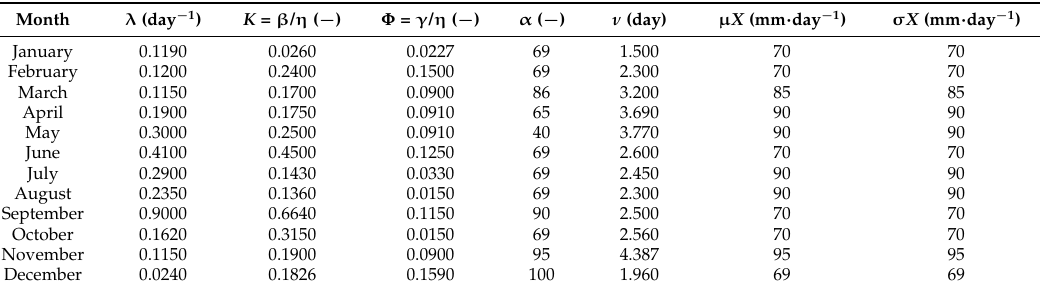
Table 2. Bartlett–Lewis Rectangular Pulse (BLRP) Parameter Estimation.